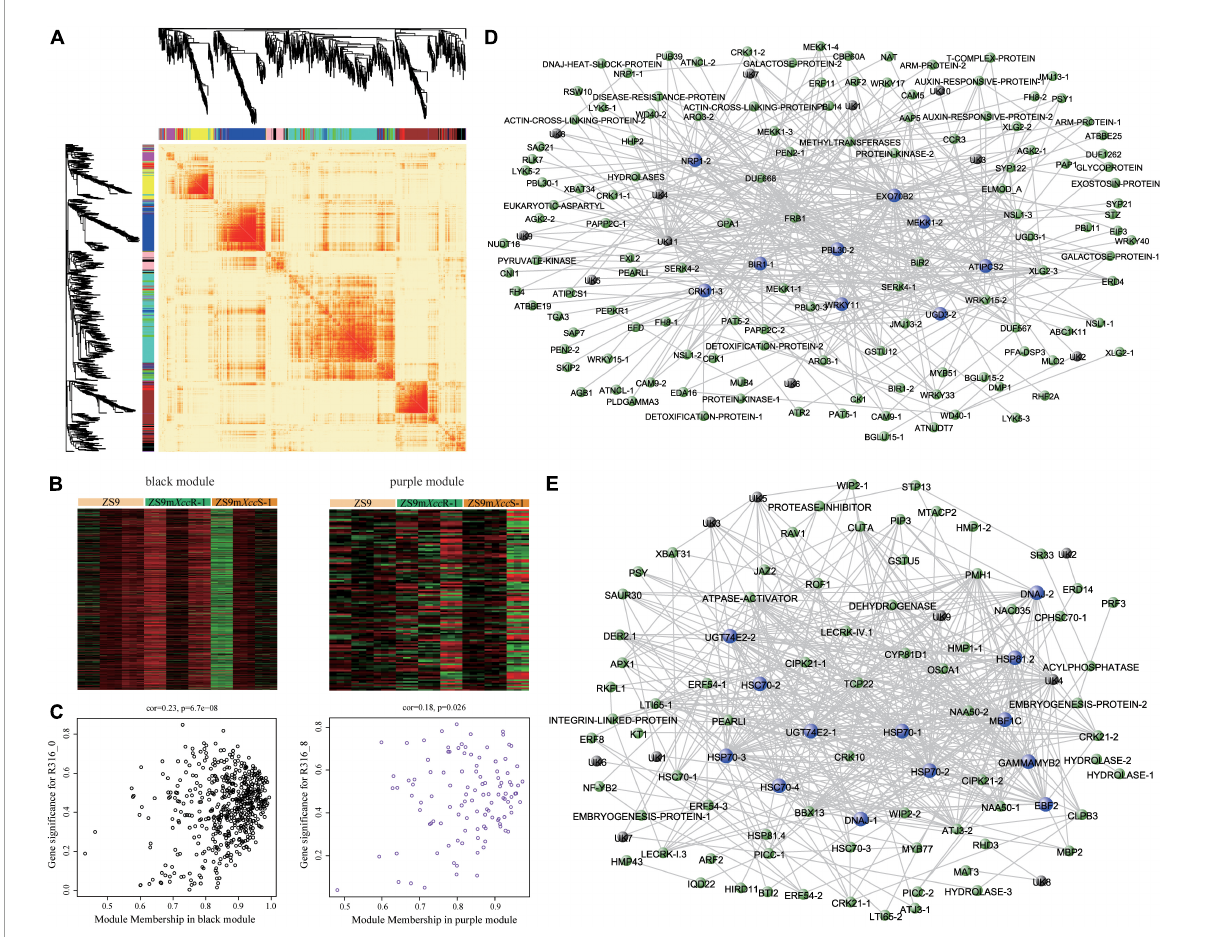
FIGURE6 Weighted gene co-expression network analysis identifies hub genes functioning in Xcc resistance. (A) Heatmap plot showing patterns of differential gene expression across modules. Colored bars below dendrograms indicate respective modules. Color intensity represents the level of expression similarity among genes. (B) Expression heatmaps of DEGs clustered in black (left) and purple (right) modules. (C) Scatter plots displaying correlation relationships between gene-modules and gene-traits. Weighted gene co-expression networks of the black (D) and purple (E) modules. Highly connected hub genes are indicated by blue nodes. Black nodes represent genes of unknown